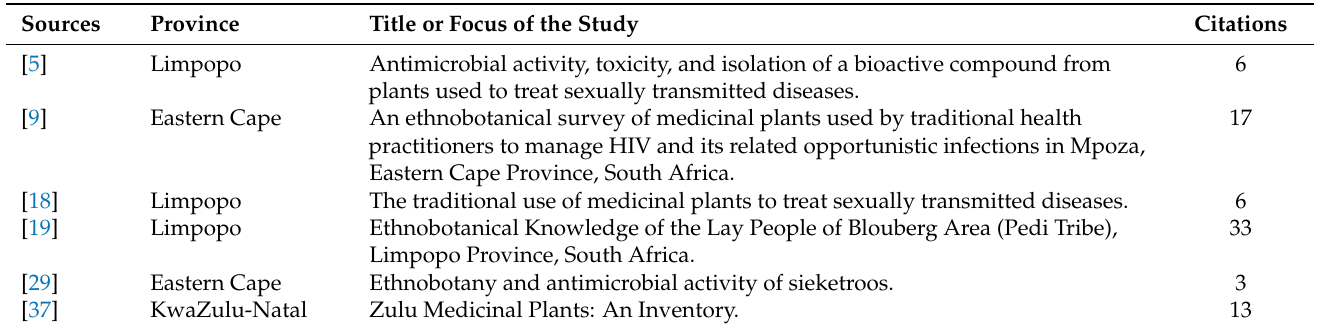
Figure 1. Distribution (by Province) of the literature sources used in the current study. Table 1. An overview of literature documenting the use of medicinal plants for managing and treating STIs and related opportunistic infections in South